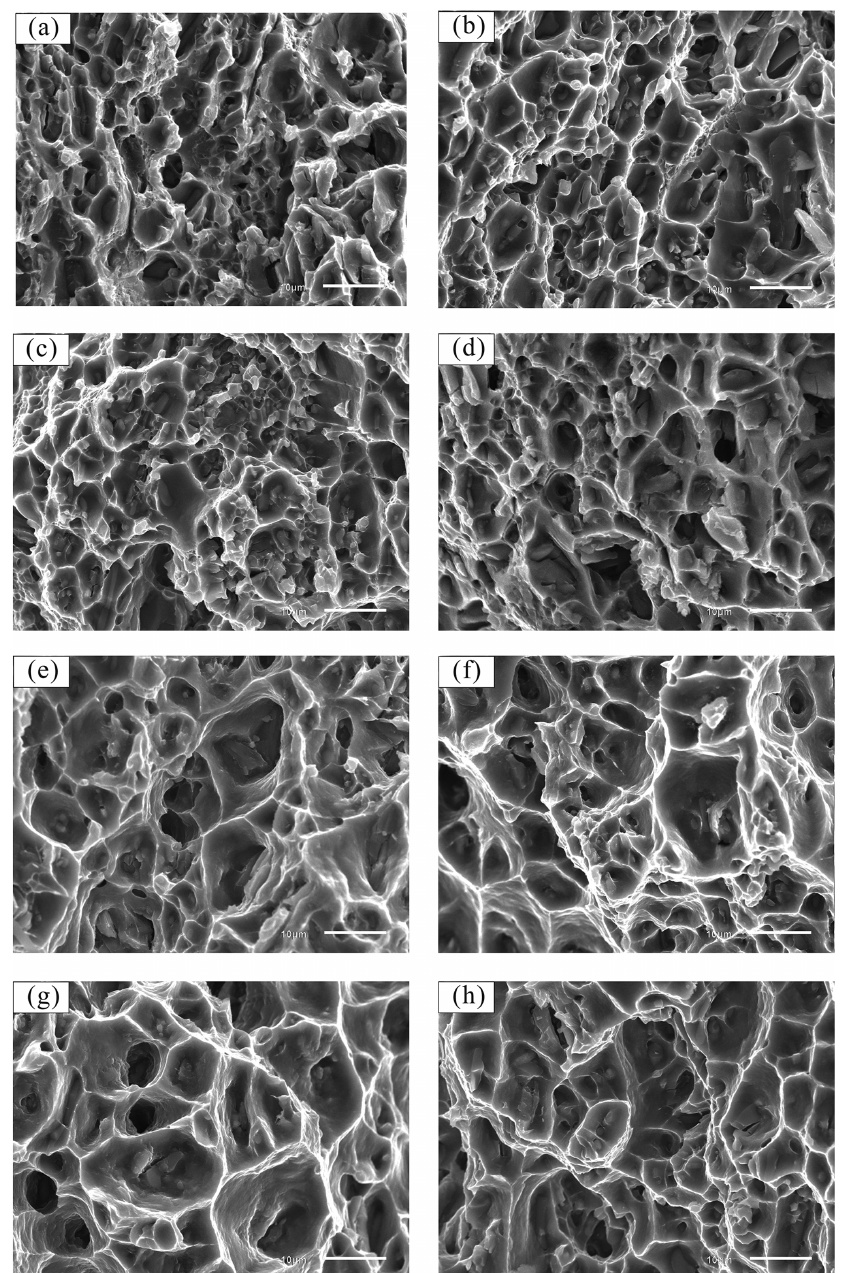
Figure 7: The fracture morphologies of tensile samples of alloy 2618-Ti and 2618 at different